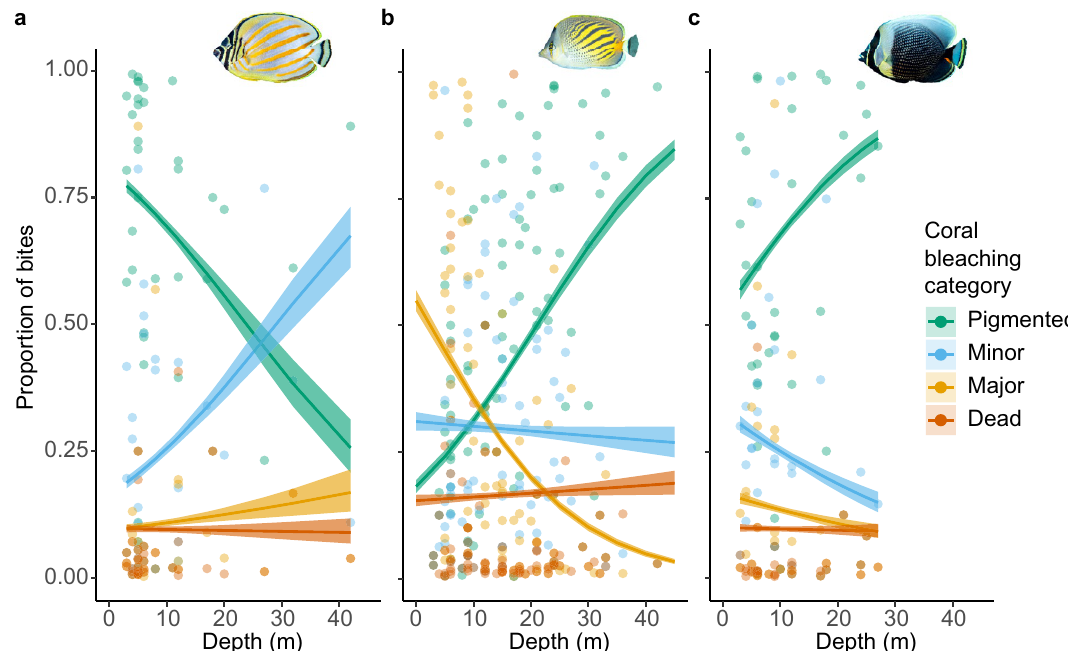
Figure 4. The proportion of bites taken from coral colonies of varying health, along a shallow-mesophotic depth gradient for three obligate corallivore butterflyfish species; ( a ) Chaetodon ornatissimus , ( b ) Chaetodon pelewensis , and ( c ) Chaetodon reticulatus